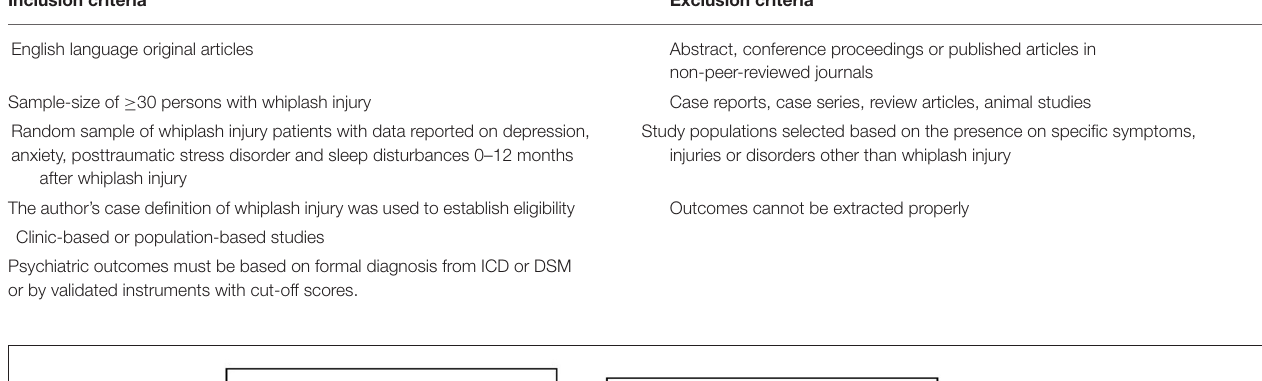
TABLE 1 | Inclusion and Exclusion criteria. Inclusion criteria